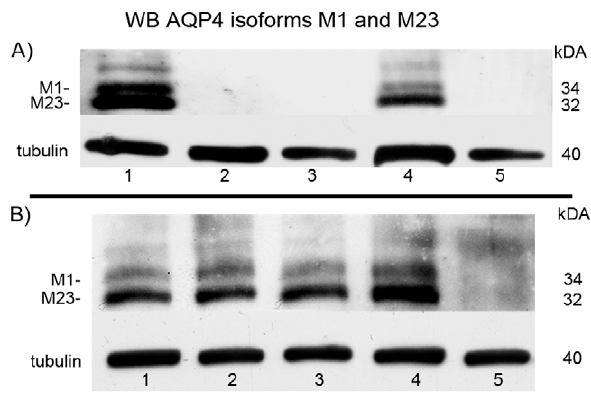
Figure 3. Western blot against AQP4. (A) C6-system: the lower band (32 kDA) represents the AQP4 isoform M23 and the upper band (34 kDA) the isoform M1. Rat control brain (lane 1), C6 cell culture (lane 2), extracranial implanted C6 cells (lane 3), intracerebral implanted C6 cells (lane 4) and C6 cells implanted into the rat flank (lane 5). Tubulin was used as loading control for these samples (40 kDA). (B) RG-2- system: Control rat brains (lane 1 and 3) and Intracerebral RG-2 cell tumors (lane 2 and 4) are positive for AQP4. The RG-2 cell culture (lane 5) is negative. The M23 AQP4 isoform always shows a stronger band than the M1 isoform. Tubulin was used as loading control for these